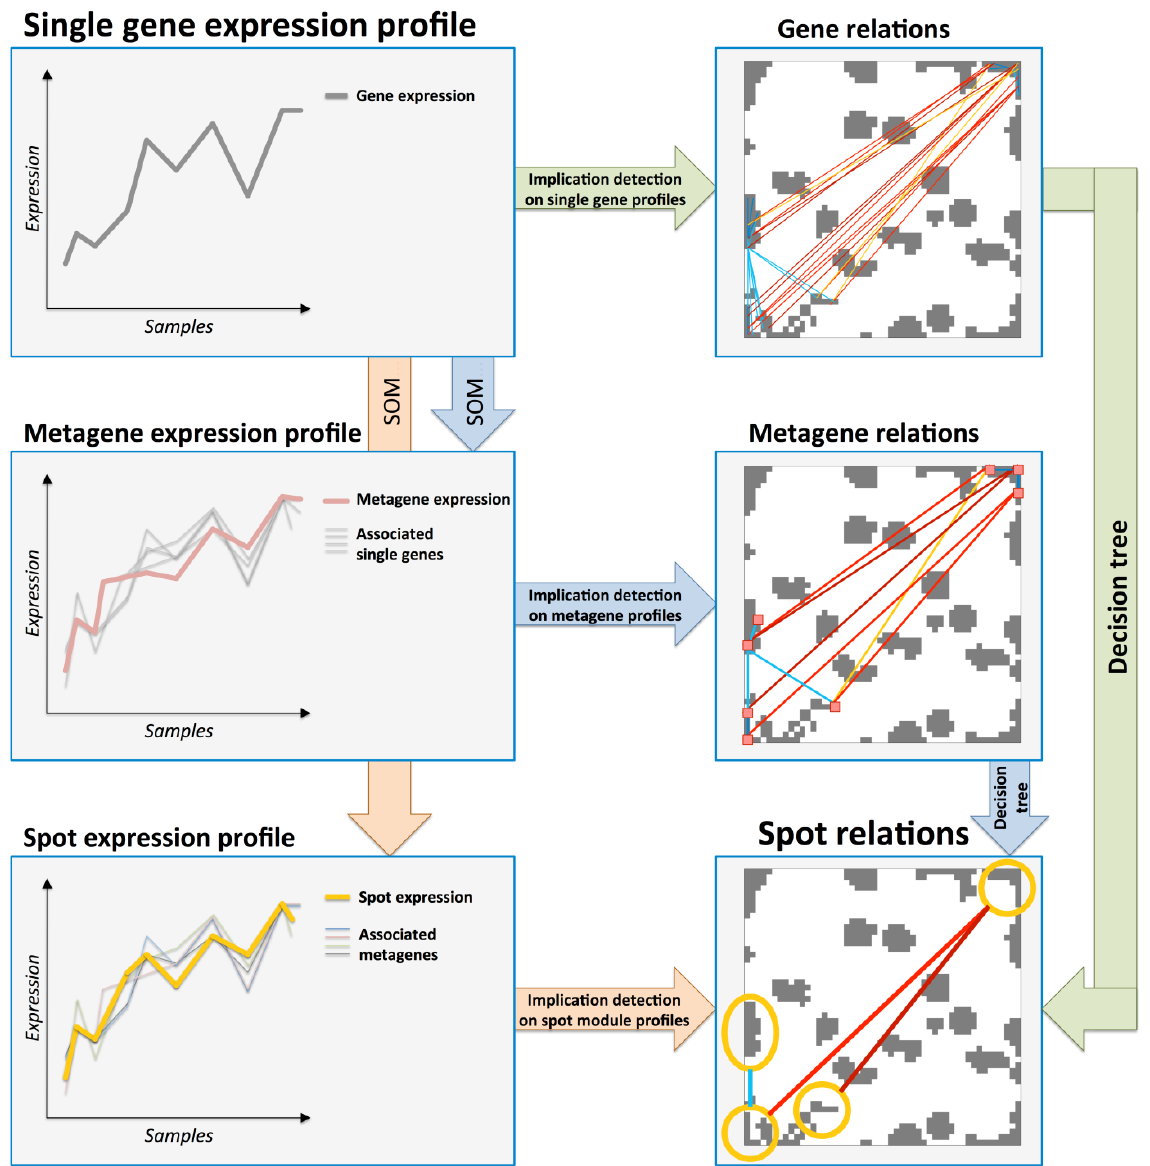
Figure 2: Three levels of expression information used to extract Boolean implications. Single genes, metagenes and spot clusters (from top to bottom): Vertical transitions are accomplished by information aggregation via SOM and the decision tree (left and right parts, respectively), horizontal transition by Boolean implication analysis on the respective data level. There are three alternative options to derive spot relations from the original single gene data; by using gene expression profiles, by using metagene expression profiles and by using spot expression profiles directly (see green, blue and orange horizontal arrows,